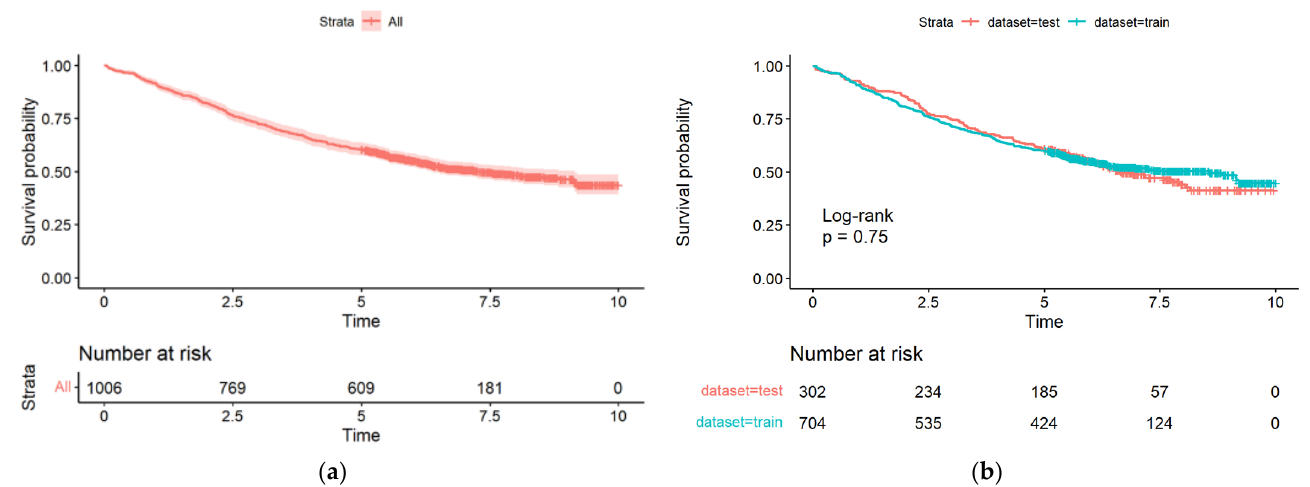
Figure 1. Kaplan–Maier survival curves for ( a ) all patients; ( b ) between derivation “train” dataset and validation “test” dataset.